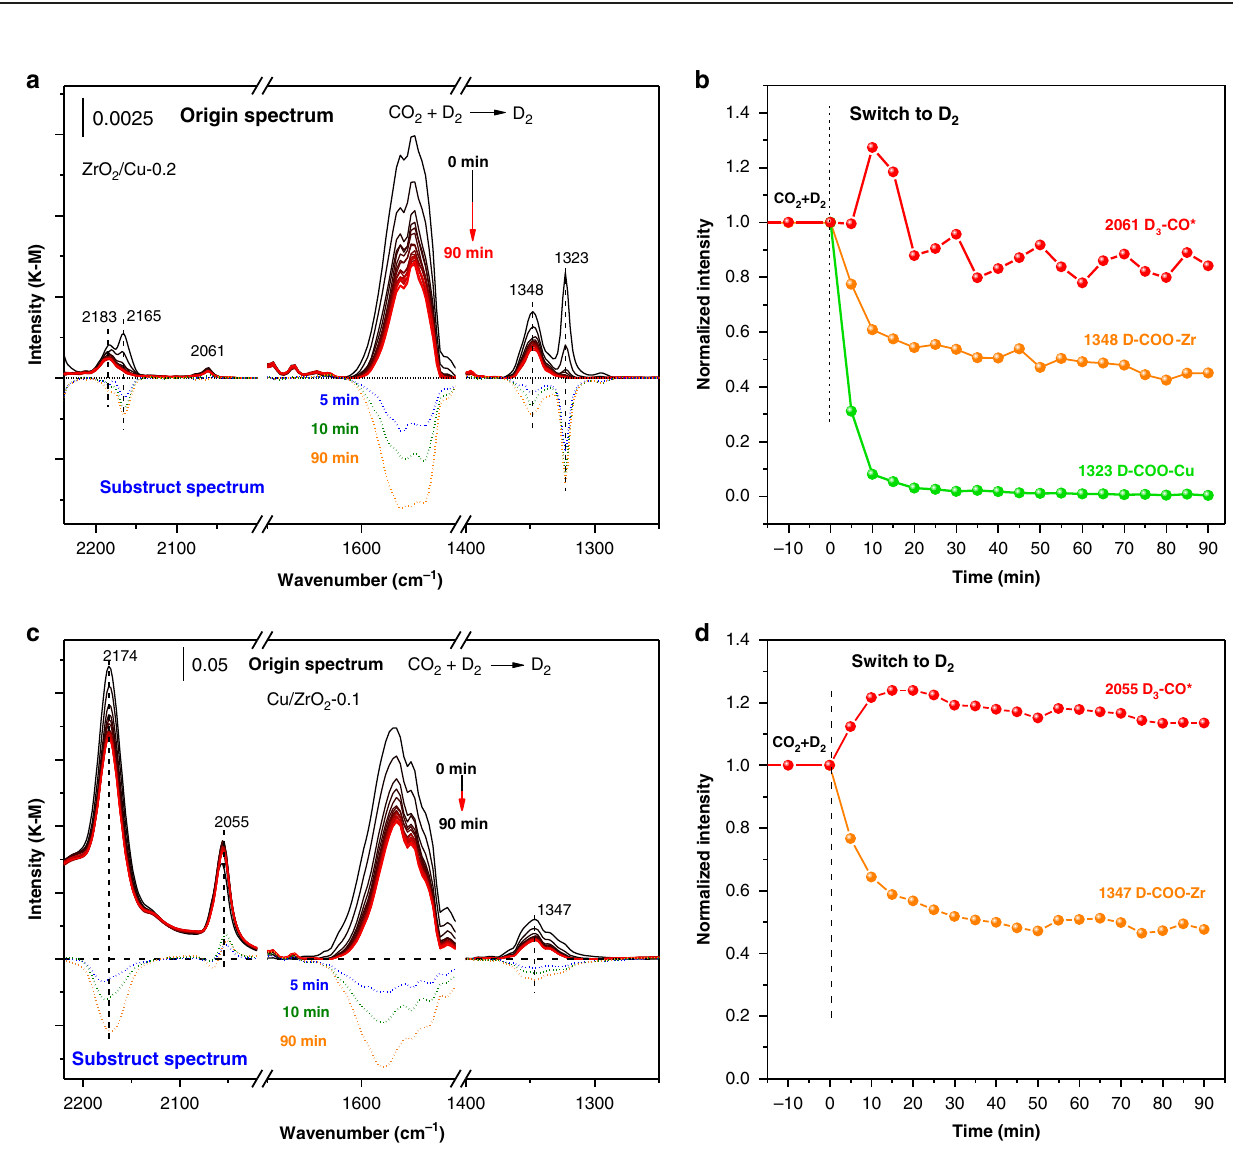
Fig. 5 In situ DRIFTS observation of surface species with isotope exchange. a , c In situ DRIFT spectra of surface species of the ZrO 2 /CuO-0.2 and Cu/ ZrO 2 -0.1 catalysts in the CO 2 + D 2 fl ow and subsequently cut off the CO 2 in the D 2 fl ow for 90 min (the upper panel, black to red lines). The spectra in the bottom showed the spectrum at 5, 10 and 90 min differentiate spectra to the one at 0 min, 5 min (blue dash line), 10 min (green dash line), 90 min (orange dash line). b , d The Normalized intensity of the IR peaks of the surface formate and methoxy as a function to reaction time on ZrO 2 /CuO-0.2 and Cu/ ZrO 2 -0.1 catalysts. The infrared intensity of the species reaching steady state at 0 min of D 2 or namely the 90 min in the CO 2 + D 2 fl ow has been arbitrarily scaled as 1 (Reaction conditions: 2 ml min − 1 CO 2 + D 2 ml min − 1 H 2 , 0.1 MPa, 493 K). D 3 -CO* (red dotted line), D-COO-Zr (orange dotted line; ʋ